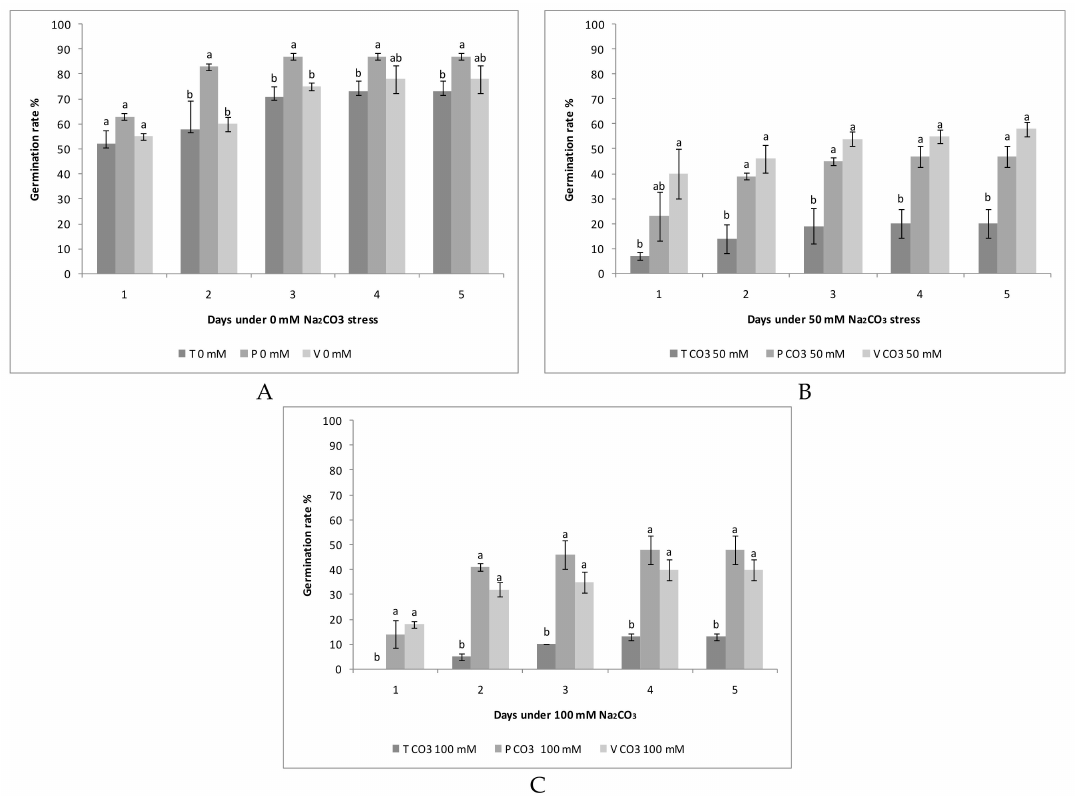
Figure 6. Comparisons between Titicaca (T), Puno (P) and Vikinga (V) cultivars under 0 mM Na 2 CO 3 ( A ), 50 mM Na 2 CO 3 ( B ), 100 mM Na 2 CO 3 ( C ) stresses. Di ff erent letter means significant di ff erences, according to Tukey test. Error bars indicate mean ±